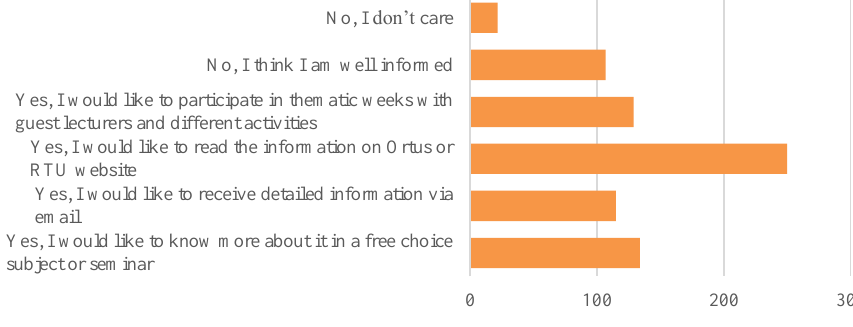
Fig. 5. Answers to the survey's question:’ Would you like to know how changing your daily habits can reduce your impact on the environment?’ In the answers on how the respondents would like to receive this type of information, the possibility to view such information on the university websites gained the most